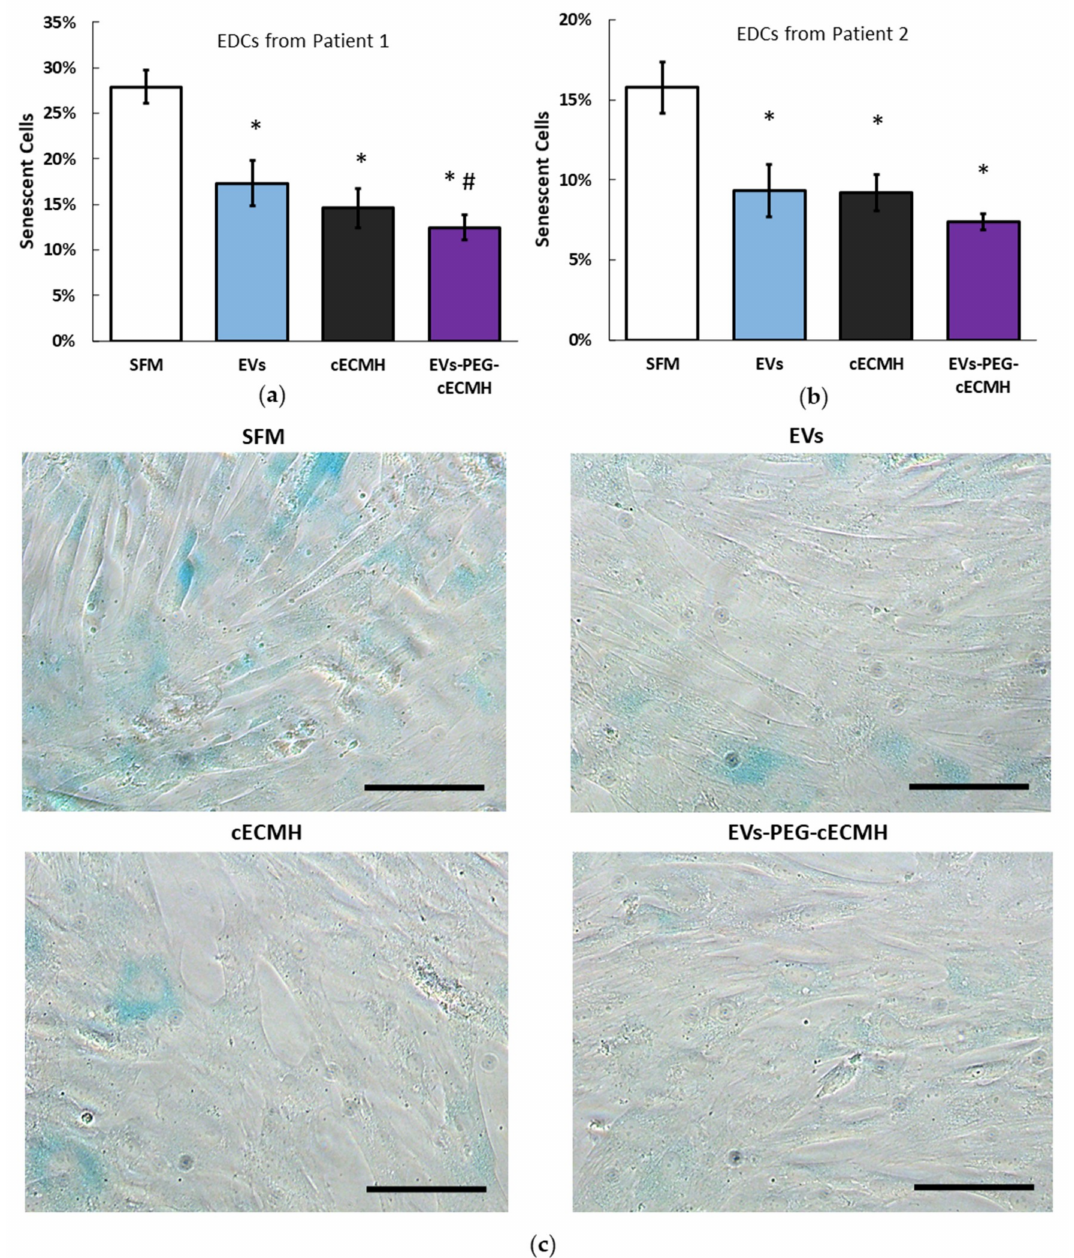
Figure 4. Bioactivity of EVs alone, cECMH, and EVs–PEG–cECMH, measured as anti-senescent effect. ( a ) Percentage of senescent EDCs from patient 1 under basal conditions and under exposure to EVs alone, cECMH alone, or EVs–PEG–cECMH ( n = 3). ( b ) Percentage of senescent explant-derived cells (EDCs) from patient 2 under the different conditions ( n = 3). ( c ) Optical microscopy images from EDCs (senescent cells in blue) from patient 1 under the different conditions. * p < 0.01 with respect to serum-free media (SFM). # p < 0.05 with respect to the EVs group. Scale bars correspond to 100 µ m. cECMH, cardiac extracellular matrix hydrogel; PEG, polyethylene glycol; EVs, extracellular